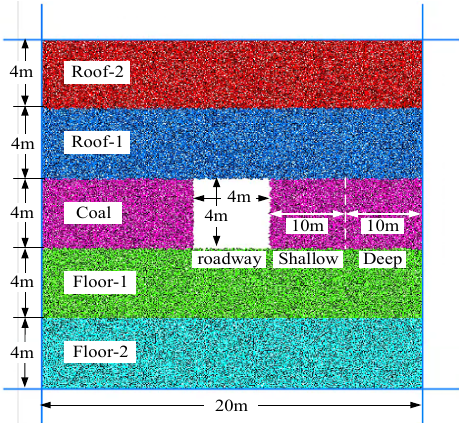
Figure 3. Particle flow model of roadway surrounding rock.